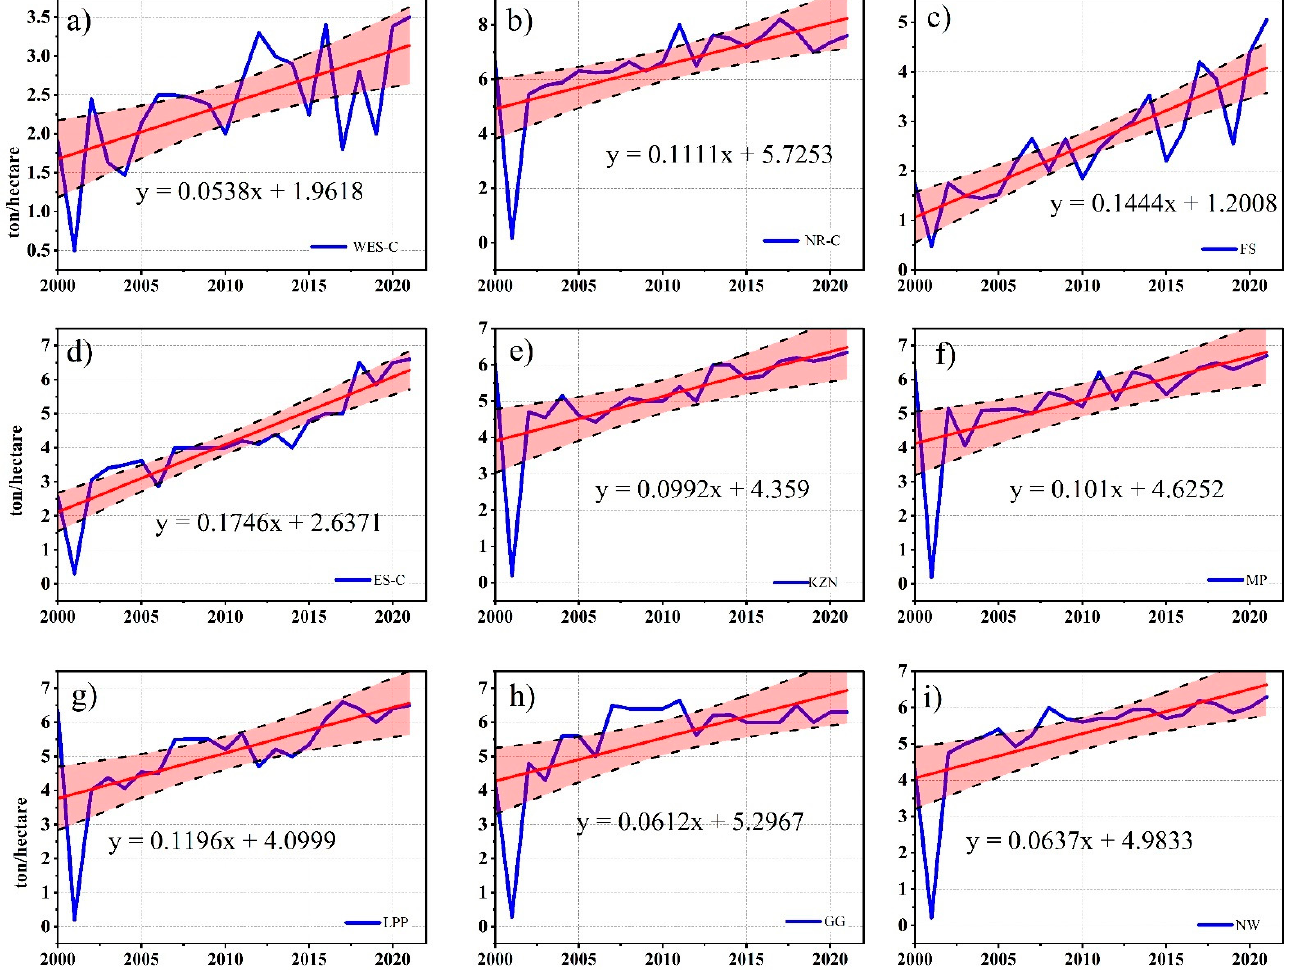
Figure 3. Evolution of wheat yield. Evolution of wheat yield (ton/hectare) between 2000 and 2020 in South Africa on a provincial level: ( a ) WES-C; ( b ) NR-C; ( c ) FS; ( d ) ES-C; ( e ) KZN; ( f ) MP; ( g ) LPP; ( h ) GG; ( i ) NW.